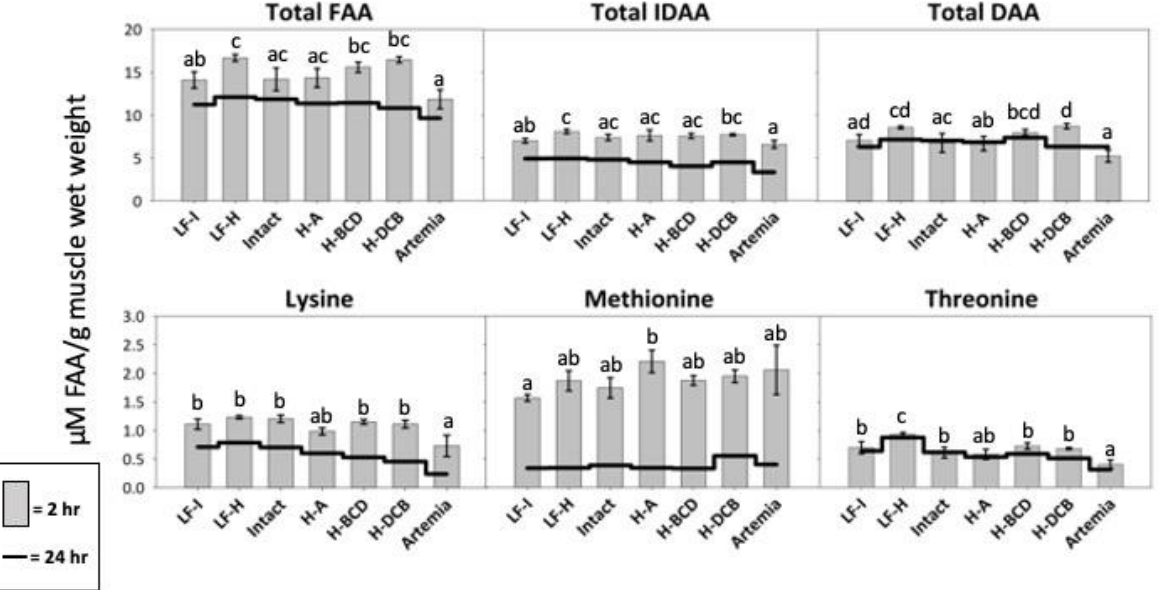
Figure 8. Muscle FAA levels in LMB after 3 weeks of feeding. The gray bars represent FAA levels 2 h after feeding. The black line indicates FAA physiological baseline. Different letters indicate statistical difference at p value <0.05. Table 5. Postprandial FAA composition in muscle.